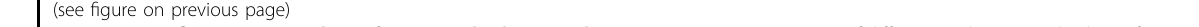
Fig. 4 Immuno fl uorescence analysis of 2D cortical cultures at day 70. A Representative images of differentiated 2D cortical cultures from FMRP- WT and FMRP-KO hiPSCs at day 70 immunolabeled with anti-GFAP antibody (red) and stained with DAPI for nuclei visualization (blue). Scale bar: 100 μ m. B Quanti fi cation of mean GFAP fl uorescence signal intensity (* p < 0.05 KO vs WT, MW test; n = 20/2/1, FOVs/ cultures/differentiation batches). C Representative immuno fl uorescence and transmitted images of glutamatergic synapses at day 70 in 2D cortical cultures differentiated from FMRP-WT (top) and FMRP-KO (bottom) hiPSCs. Glutamatergic synaptic puncta are identi fi ed as positive for VGLUT1 (pre-synaptic, red) and PSD95 (post-synaptic, white), respectively. Nuclei were stained with DAPI (blue) and dendrites with anti-MAP2 antibody (green). Scale bar: 50 µm. D Representative immuno fl uorescence and transmitted images of GABAergic synapses at day 70 in 2D cortical cultures differentiated from FMRP-WT (top) and FMRP-KO (bottom) hiPSCs. GABAergic pre-synaptic puncta are shown as positive for GAD67 (red). E Bar charts representing (left) the quanti fi cation of glutamatergic and GABAergic synaptic puncta (VGLUT1 puncta WT 1950 ± 160, KO 1900 ± 130, p = 0.87, MW test; PSD95 puncta WT 2430 ± 220, KO 2470 ± 170, p = 0.9; GAD67 puncta WT 2910 ± 230 KO 2840 ± 230, p = 0.83, MW test; n = 30/2 FOVs/ differentiation batches for each genotype) and (right) VGLUT1/PSD95 colocalization, in both genotypes (VGLUT1/PSD95 WT 360 ± 40, KO 400 ± 30, p = 0.43; n = 30/2 FOVs/ differentiation batches for each